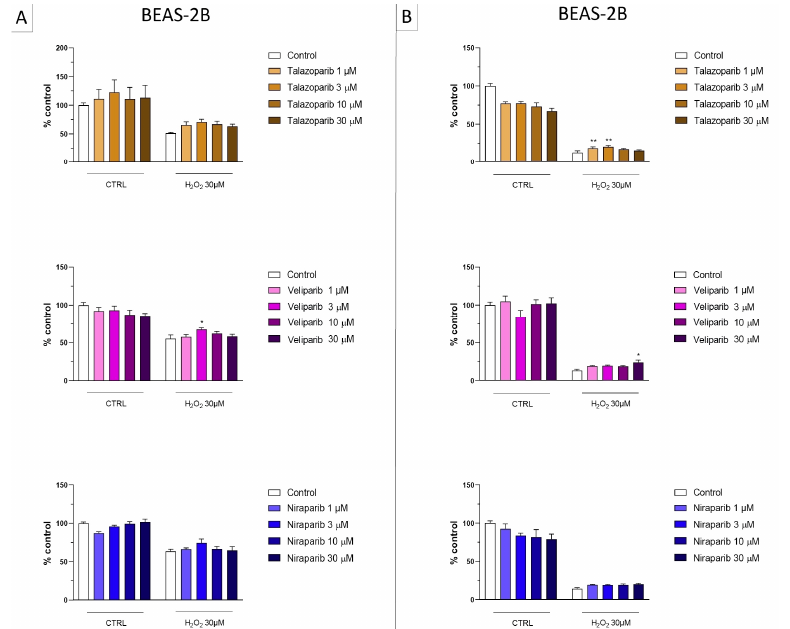
Figure 8. Effect of the clinical-stage PARP inhibitors talazoparib, veliparib, or niraparib on H 2 O 2 - induced suppression of cellular MTT-converting activity in BEAS-2B cells. Cells were treated for 2 h ( A ) or 24 h ( B ) with 30 µM H 2 O 2 ; the PARP inhibitors were applied at different concentrations (1, 3, 10, and 30 µM). * p < 0.05 and ** p < 0.01 indicate the beneficial effect of PARP inhibition to counteract the effect of oxidative stress. Data are shown as mean ± SEM of n = 5 independent experiments.